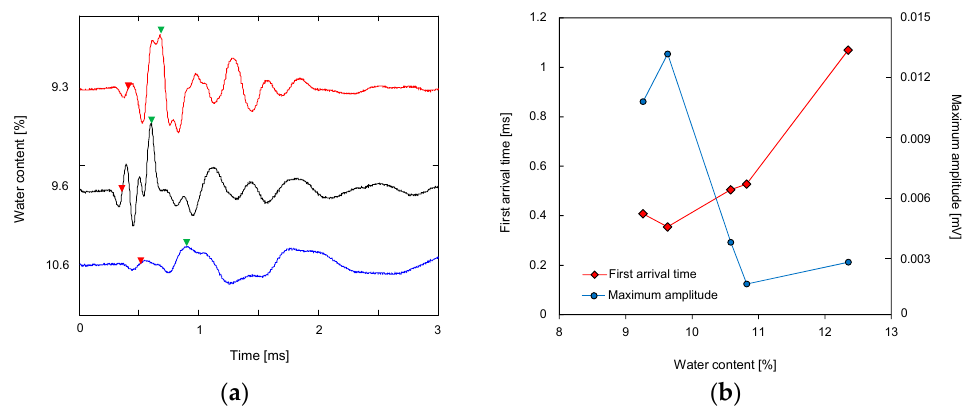
Figure 5. Results obtained from ring bender: ( a ) waveforms at different water contents; ( b ) variation in first arrival time and maximum amplitude with water contents. Red and green triangles denote the first arrival time and the time to maximum amplitude, respectively.